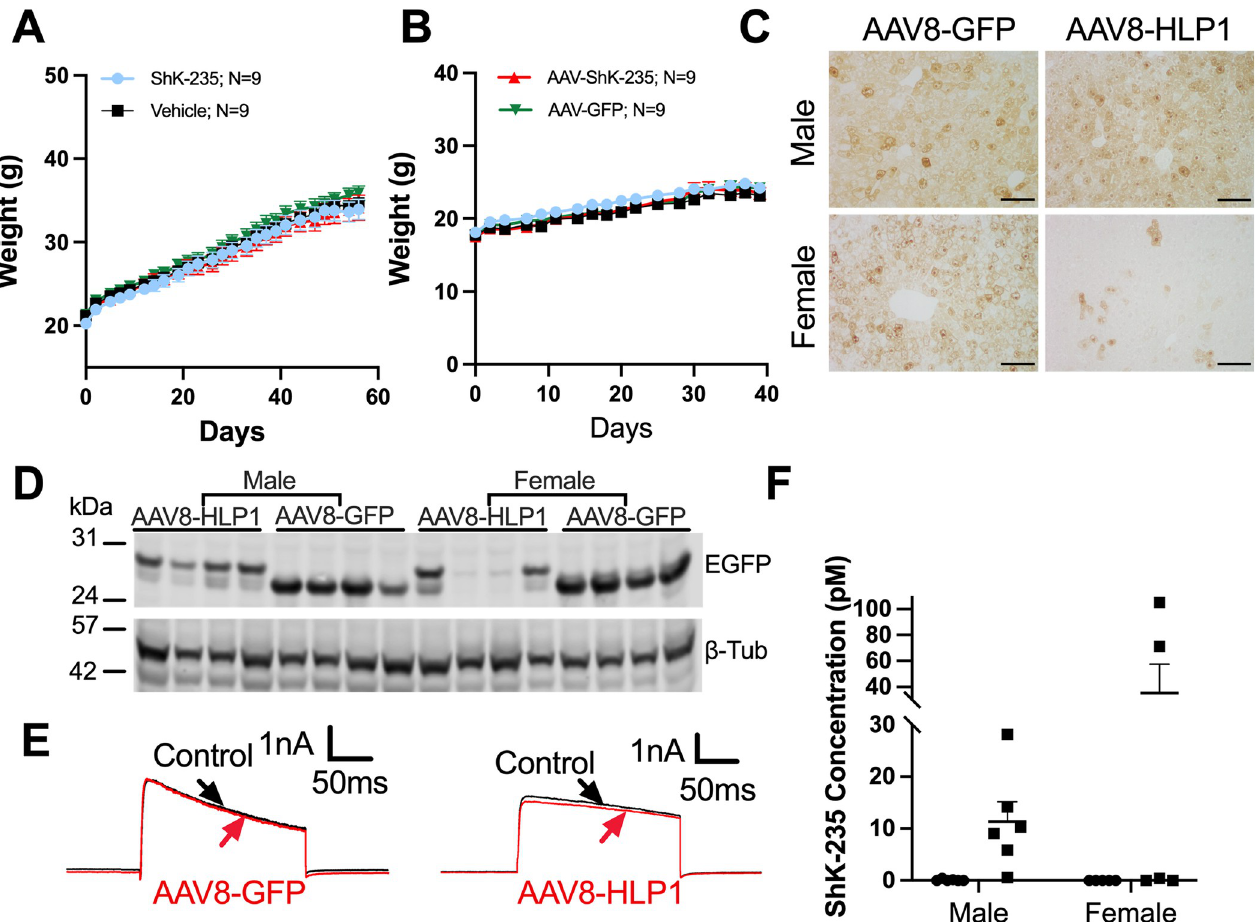
Fig 3. Lack of long-term secretion of ShK-235 by mouse hepatocytes. (A, B) Weekly weights of male (A) and female (B) mice after a single intraperitoneal injection of 2E+11 GC of AAV8-HLP1 ( ▲ ) or 2E+11 GC of AAV8-GFP ( ▼ ), or subcutaneous injection of 500 μ g/kg synthetic ShK-235 ( ● ) or of vehicle ( ■ ) every other day. N = 9 males and 9 females per group. (C) Representative IHC images of mouse livers showing EGFP expression. Scale bars, 100 μ m. (D) Western blot analysis of male and female mouse liver lysates from obesity mice that received AAV8-GFP or AAV8-HLP1 injections, with β -tubulin used as a loading control. (E) Representative whole-cell Kv1.3 currents in L929 fibroblasts stably expressing mKv1.3 before (control) and after application of serum from mice injected with AAV8-GFP or AAV8-HLP1, diluted 1:50. (F) ShK-235 concentration in serum from mice injected with AAV8-GFP ( ● ) or AAV8-HLP1 ( ■ ). N = 5–6 cells per